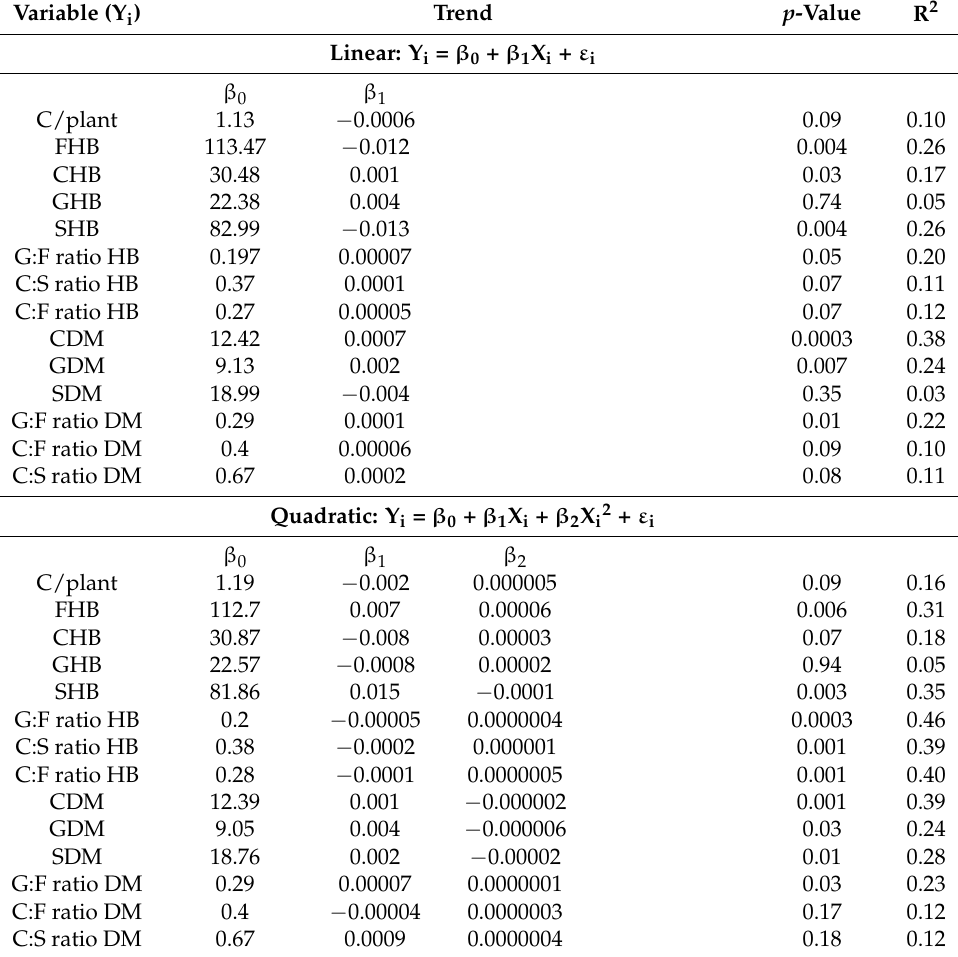
Table 5. Linear, quadratic, and cubic models for forage, stover, cob, and grains humid base (HB) and dry matter (DM)